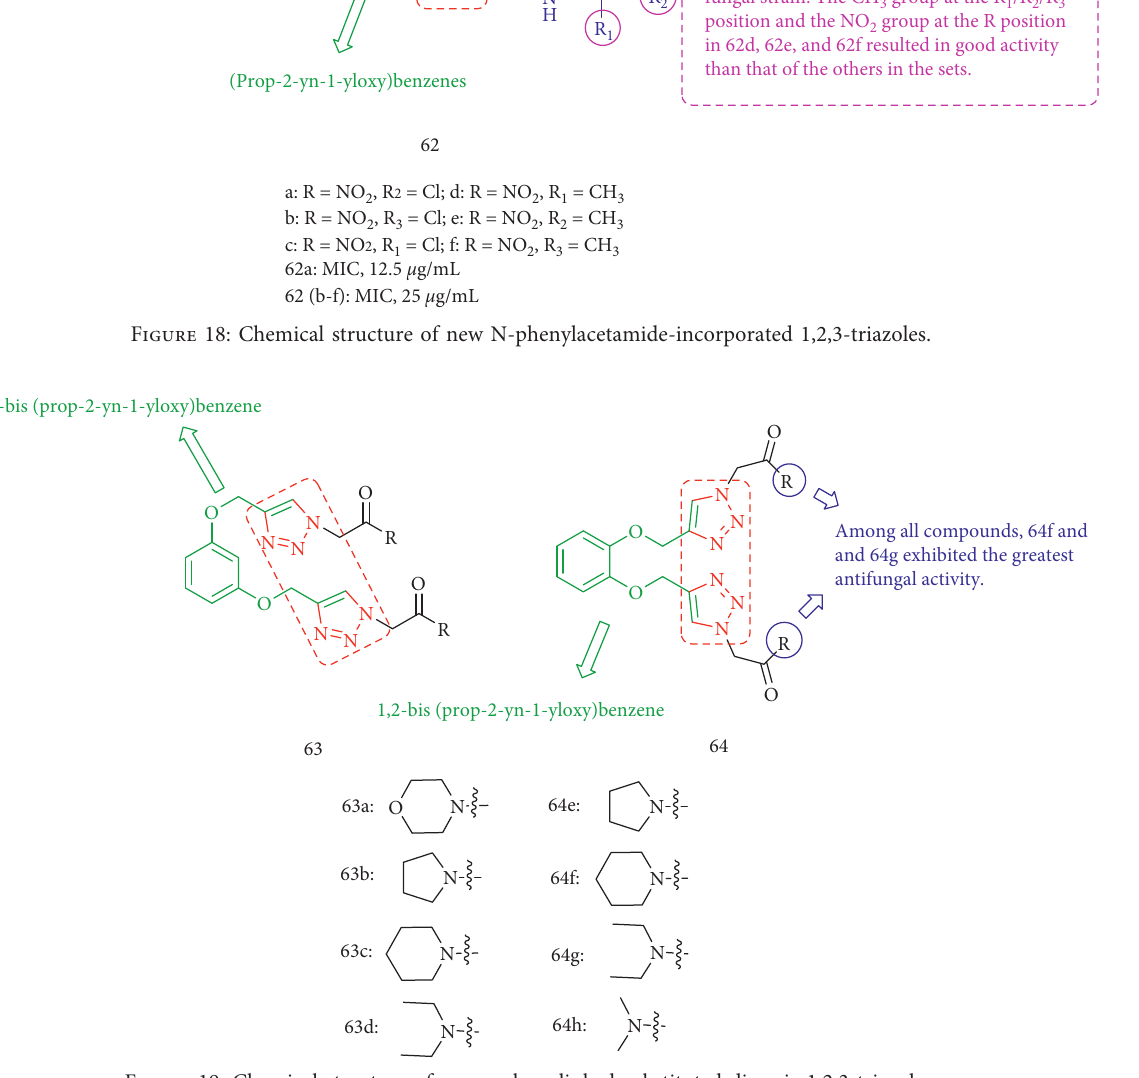
Figure 19: Chemical structure of new aryloxy-linked substituted dimeric